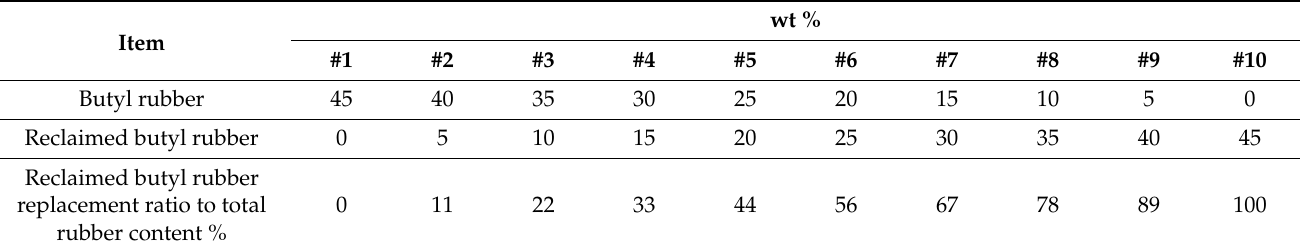
Table 1. Advanced research mixing plan.